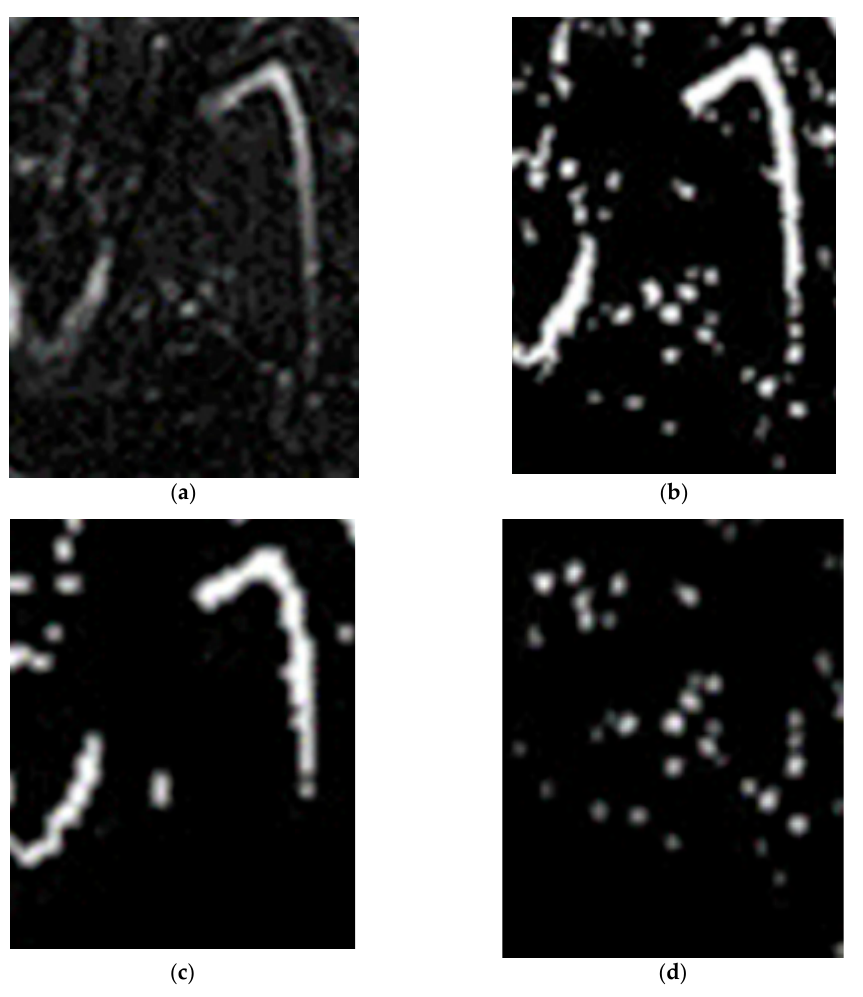
Figure 5. ( a ) Shows the 3D slice of the mouse calf region; ( b ) shows the binary version of ( a ); and ( c ) shows the results of morphological operation on ( b ); and ( d ) shows the final results of extracted IO-NPs.